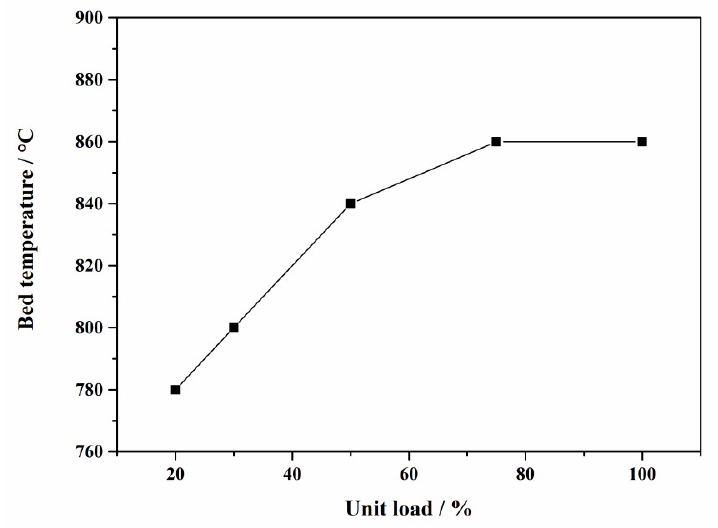
Figure 8. Boiler bed temperature varies with the load.